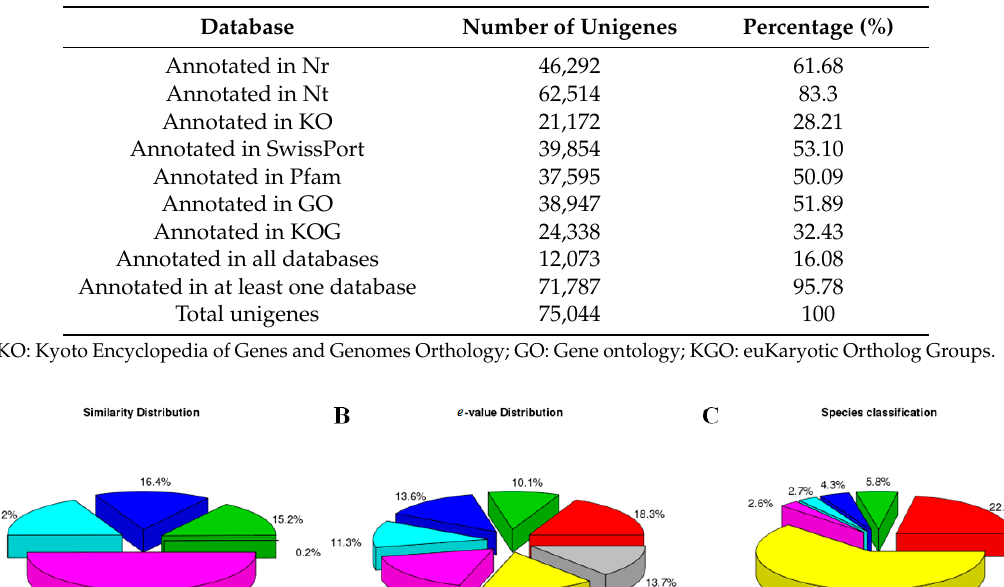
Table 3. Annotationresults of the assembled unigenes.